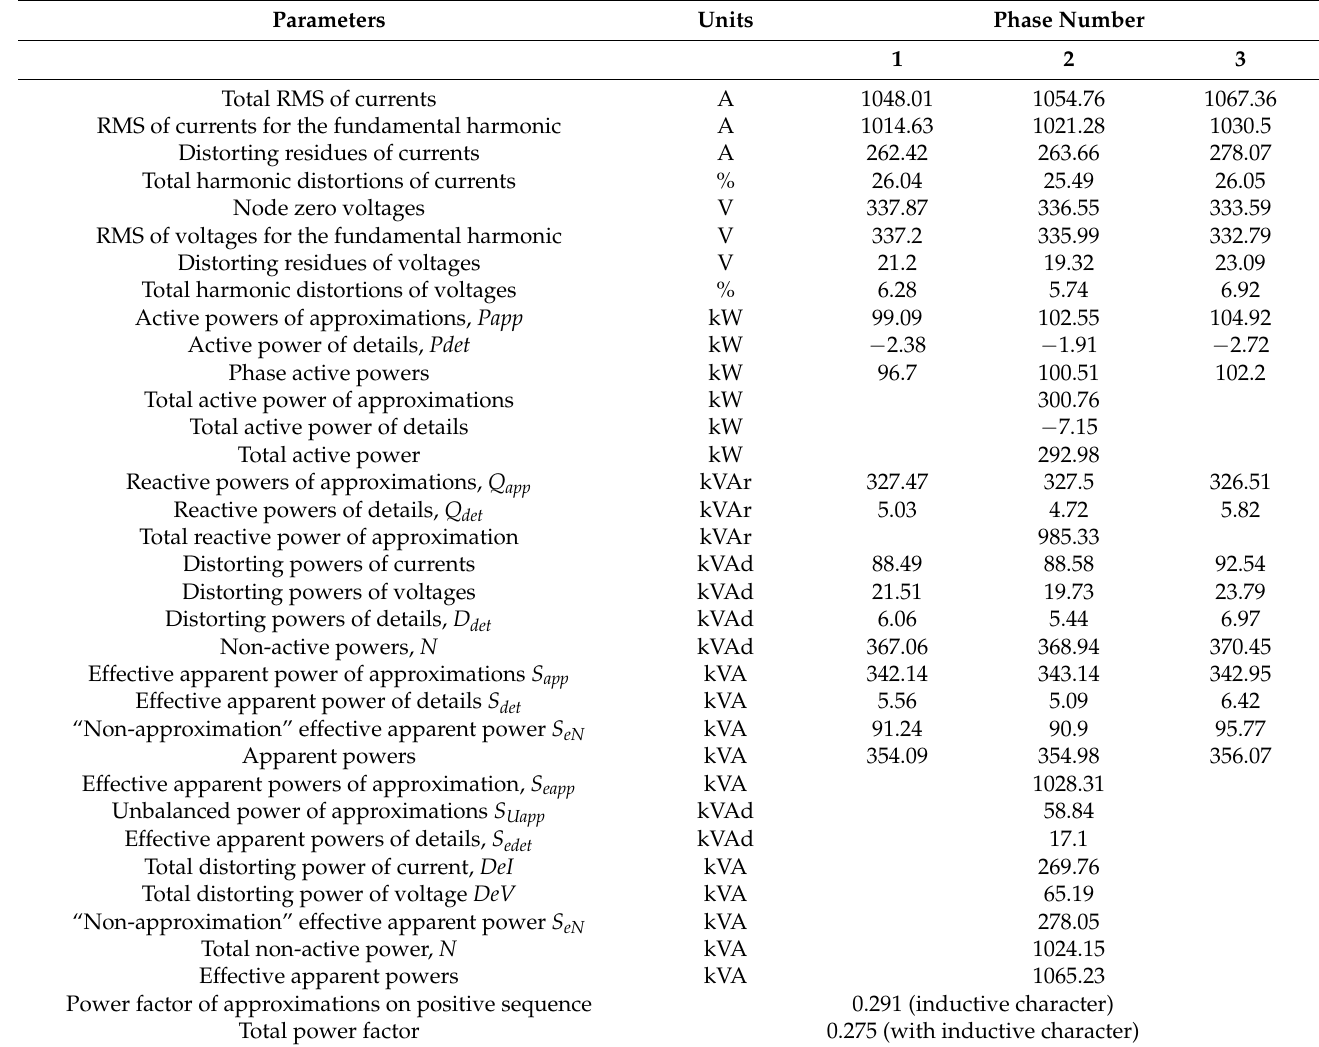
Table 2. Power quality index, powers and power factor computed with DWT and the third theory, first case study.